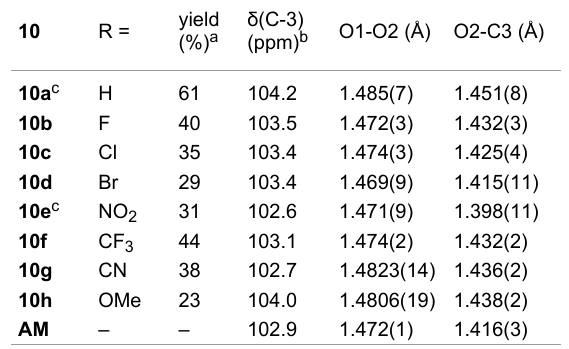
Table 3: Yields, structural and 13 C-NMR properties of 1,2,4-trioxanes 10a – h , and arthemether ( AM